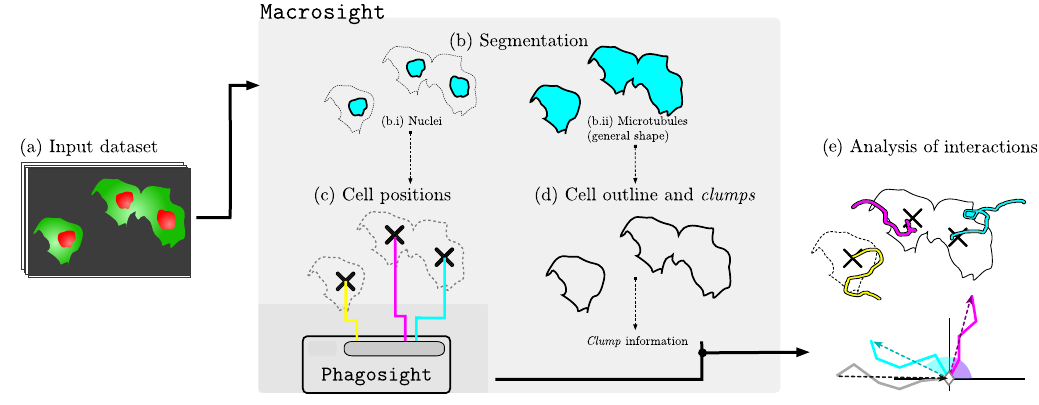
Figure 4. Illustration of the macrosight framework parts used in this work. ( a ) Illustration of a sequence of images with cells with red nuclei and green microtubules. The two fluorescent channels are segmented in ( b ) based on a hysteresis threshold where the levels are selected by the Otsu [41] algorithm. The segmentation of the red channel ( b.i ) provides the cell positions necessary to produce ( c ) the tracks of the cells using the keyhole tracking algorithm [40] (represented in cyan, magenta, and yellow). Finally, the tracks’ information is combined with the clump information ( d ) from the segmented green channel ( b.ii ) to allow analysis of movement based on contact events ( e ), producing the change of direction chart per cells in the clump. In this case, two cells interact and form a clump (magenta and cyan), whilst the other cell (yellow) does not form a clump. The diagram illustrates the change of direction of those cells that interact in the clump.